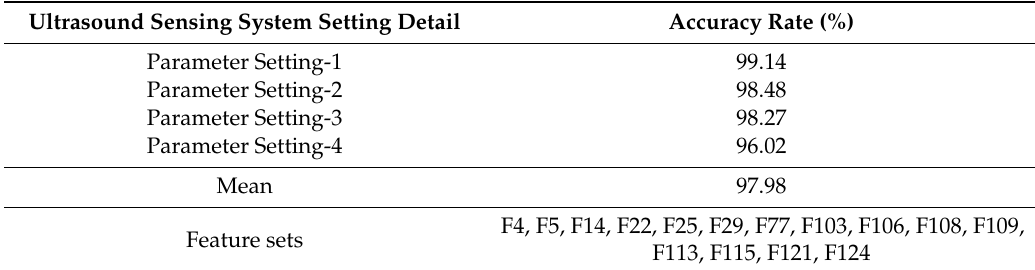
Table 14. Classification results of the SVM-enabled intelligent genetic algorithmic model when it chooses 15 universal features.